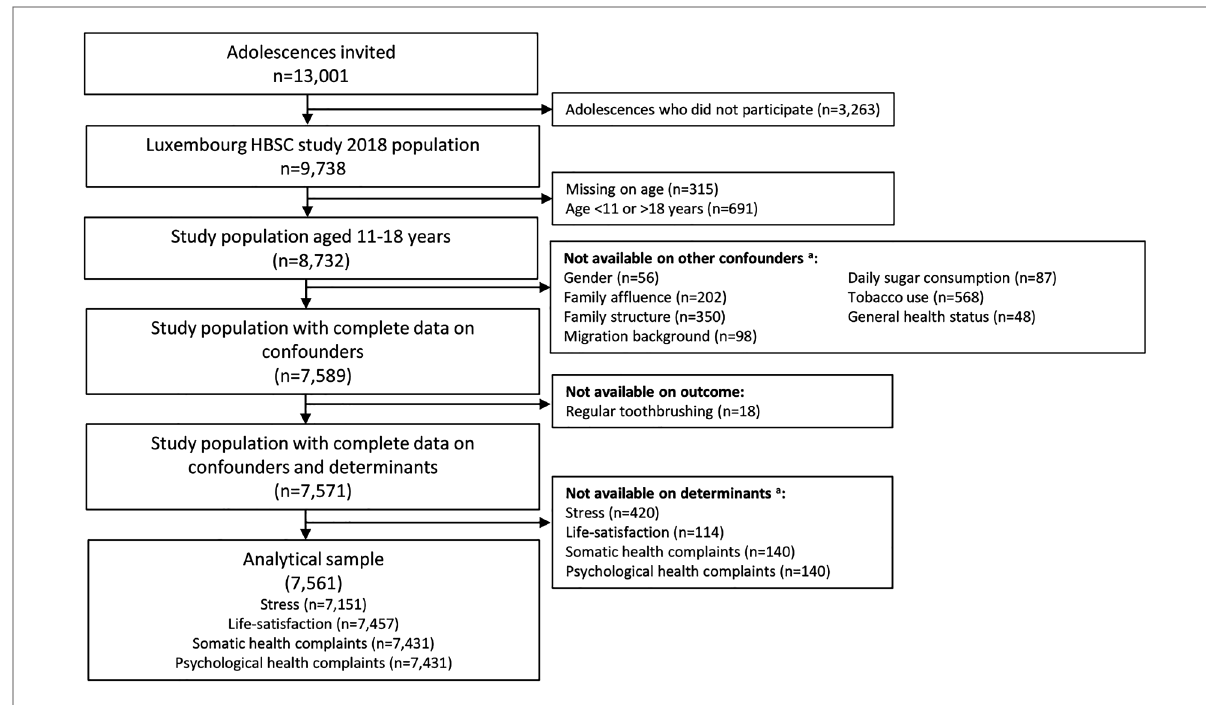
FIGURE 1 Flowchart HBSC indicates Health Behavior in School-Aged Children. Numbers are weighted by the distribution of adolescents across school grades. a Unavailable data are not mutually